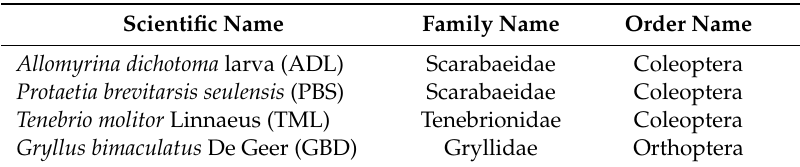
Table 1. The systematic family and order names of